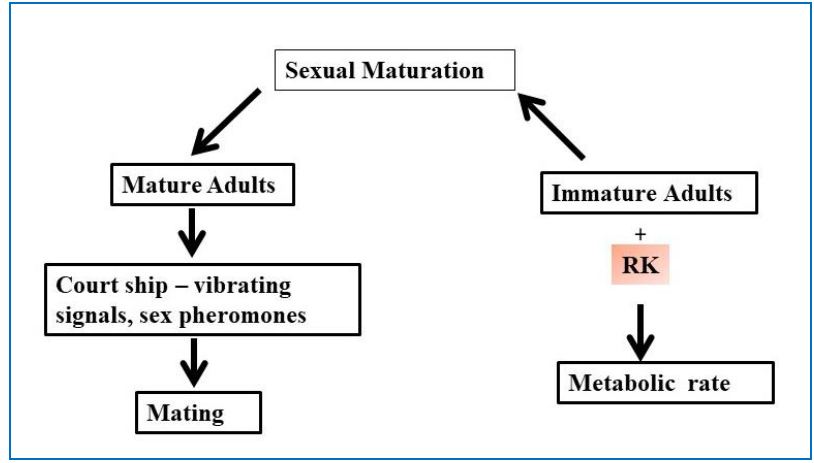
Figure 7. Schematic diagram showing the process of mating in insects and the role of RK in sexual maturation.